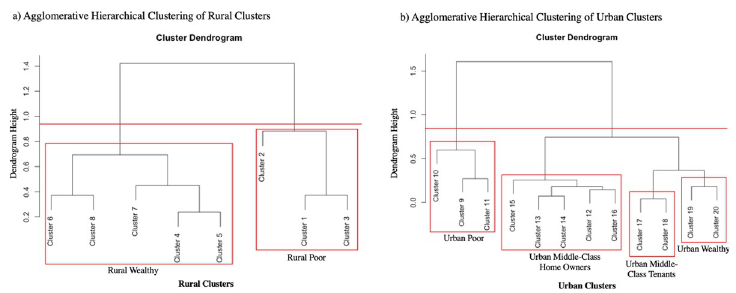
Fig 4. Agglomerative hierarchical clustering of Cameroonian rural and urban EconomicClusters based on mean scaled child height-for-age Z-score, women’s literacy score, and proportion of children who are deceased.